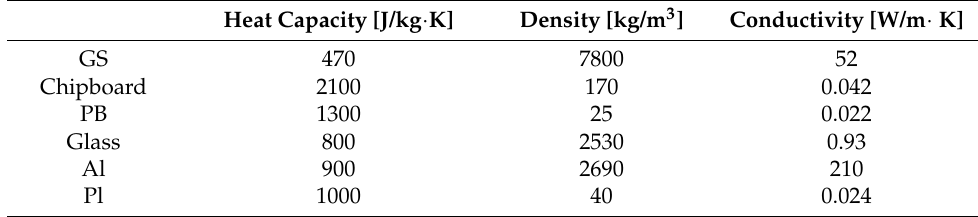
Table 4. Mechanical properties of the construction and insulation materials of the EEBLAB [29]. Characteristics